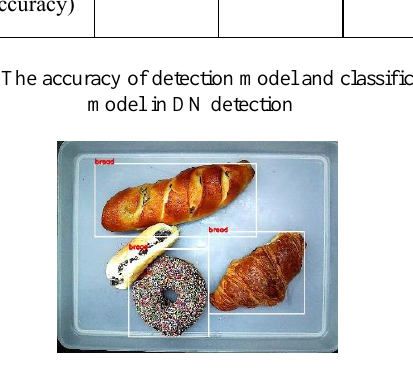
Figure 6. The missed detection image in detection stage